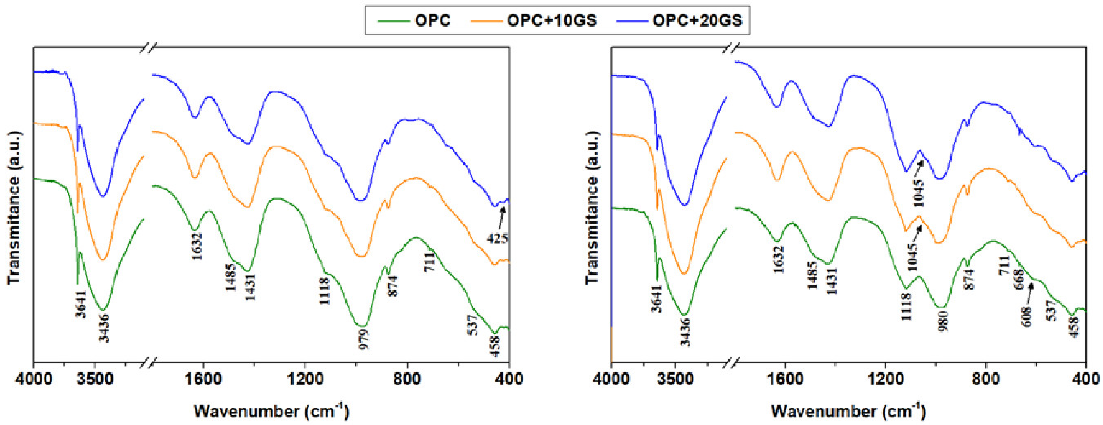
Figure 9. FTIR spectra for pastes OPC, OPC + 10GS, and OPC + 20GS soaked for 180 days in ( left ) water and ( right ) water and ( right ) sulfates.